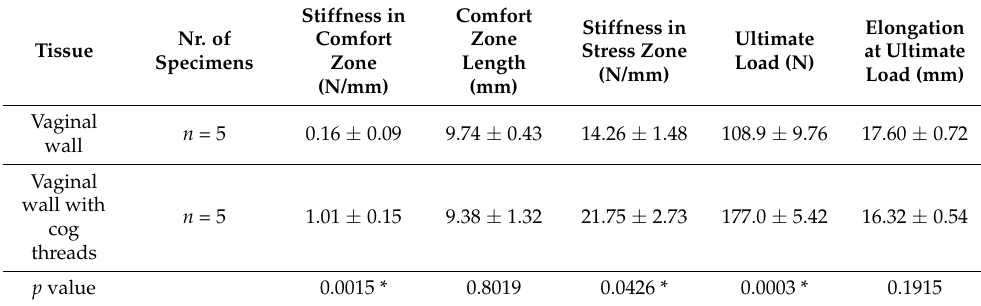
Table 1. Mechanical characteristics of sow vaginal wall during ball burst testing. Data are presented as mean ± standard error of the mean; significant group differences were determined to p < 0.05 and noted (*).